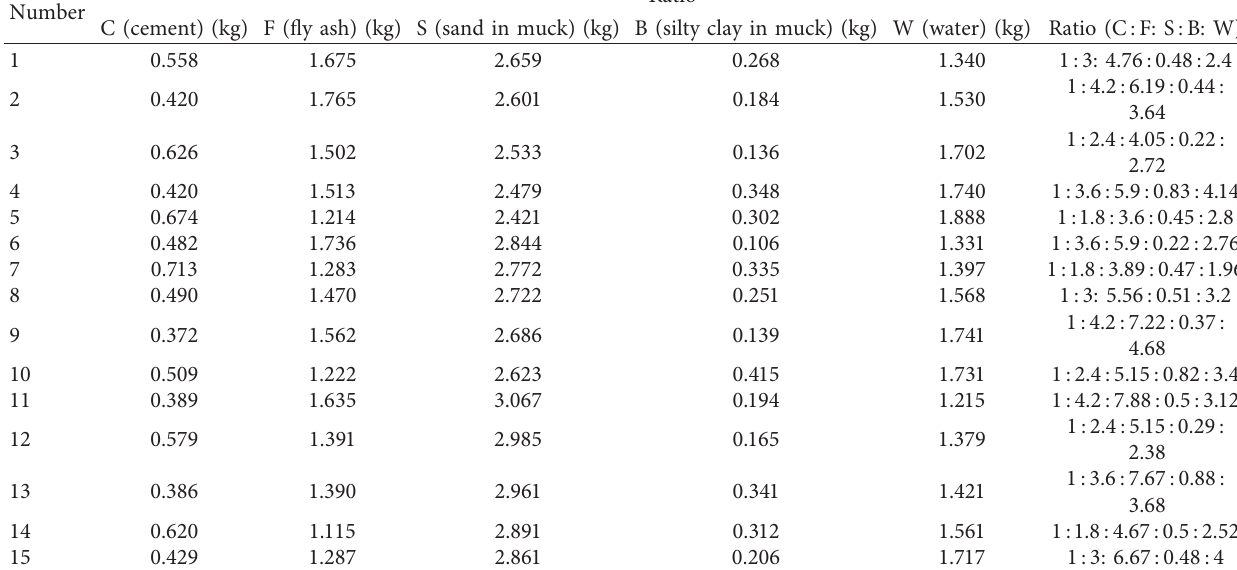
Table 4: Material proportions of uniform experimental design (6.5kg for each group).